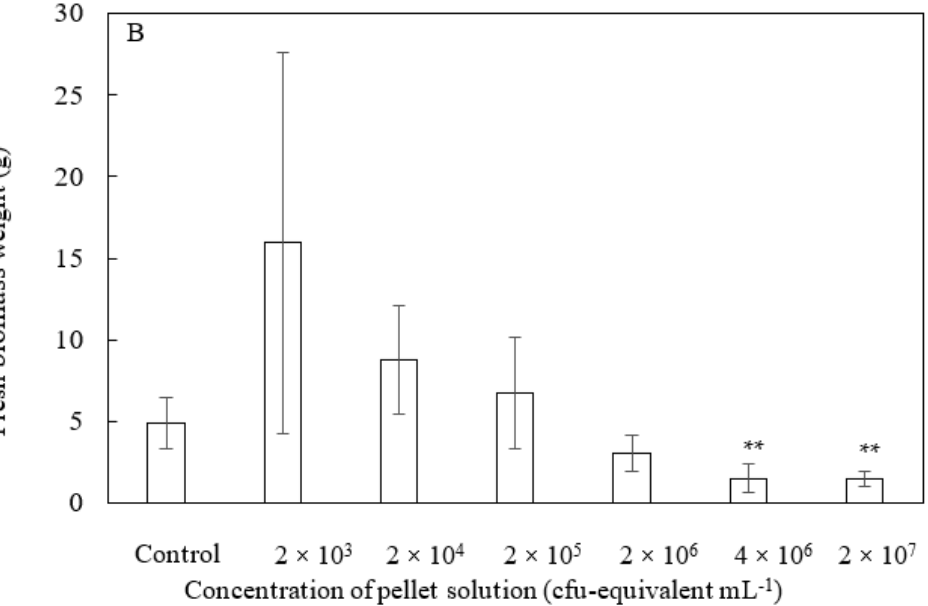
Figure 4. Fresh weight of komatsuna when supernatant ( A ) or pellet solution ( B ) was sprayed once every 3 days and cultivated for 30 days. Each bar represents the mean ± S.D. ( n = 4). Asterisks indicate significant difference with control at p < 0.01 (**).